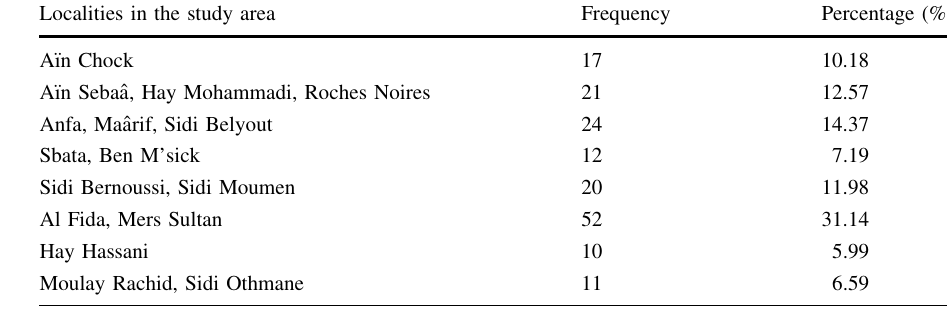
Fig. 2 Map of the selected locations for the